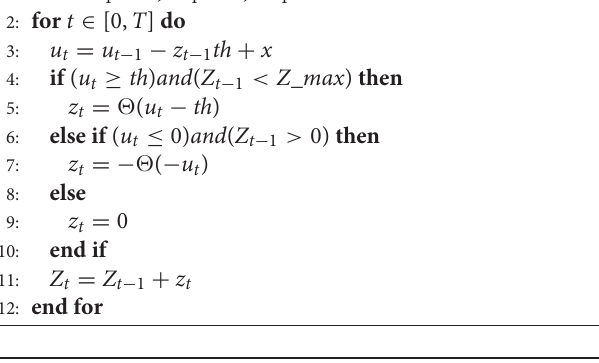
Algorithm 2 Event-based max